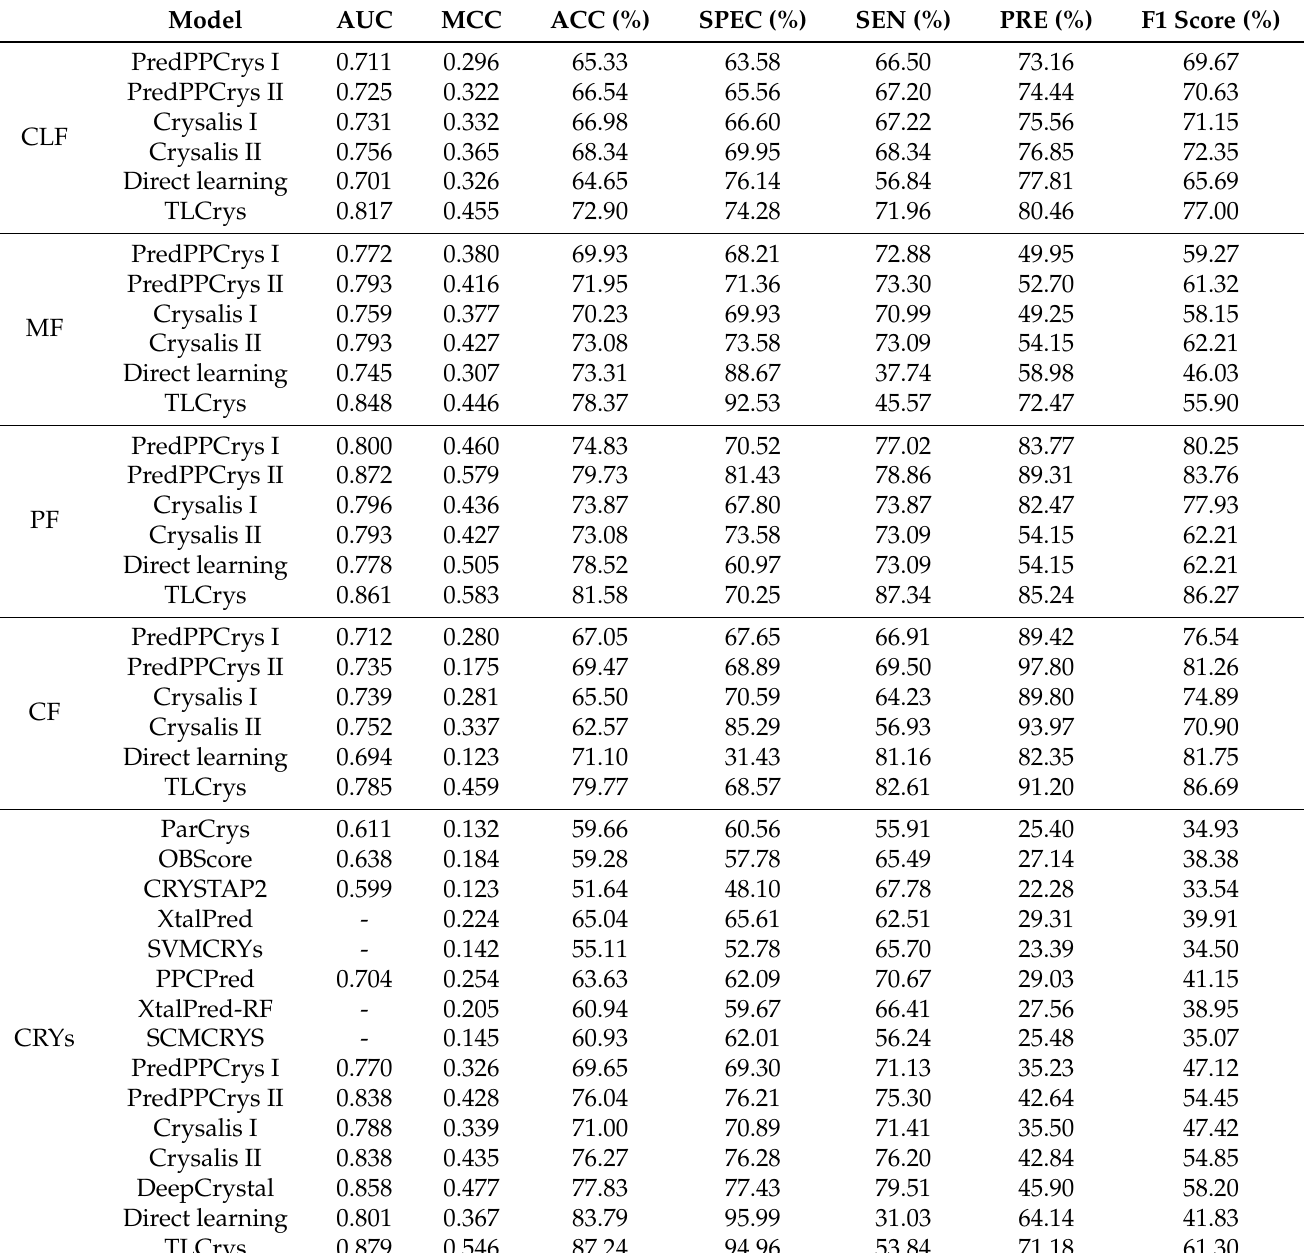
Table 3. Comparison of our two model with other methods on test